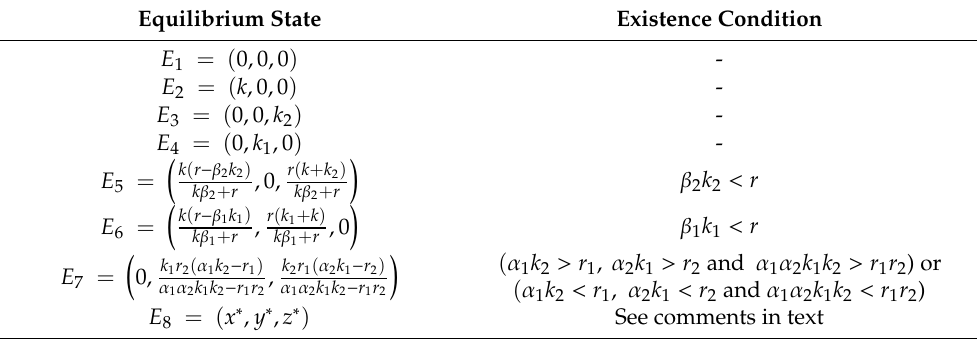
Table 1. Equilibrium states and their existence